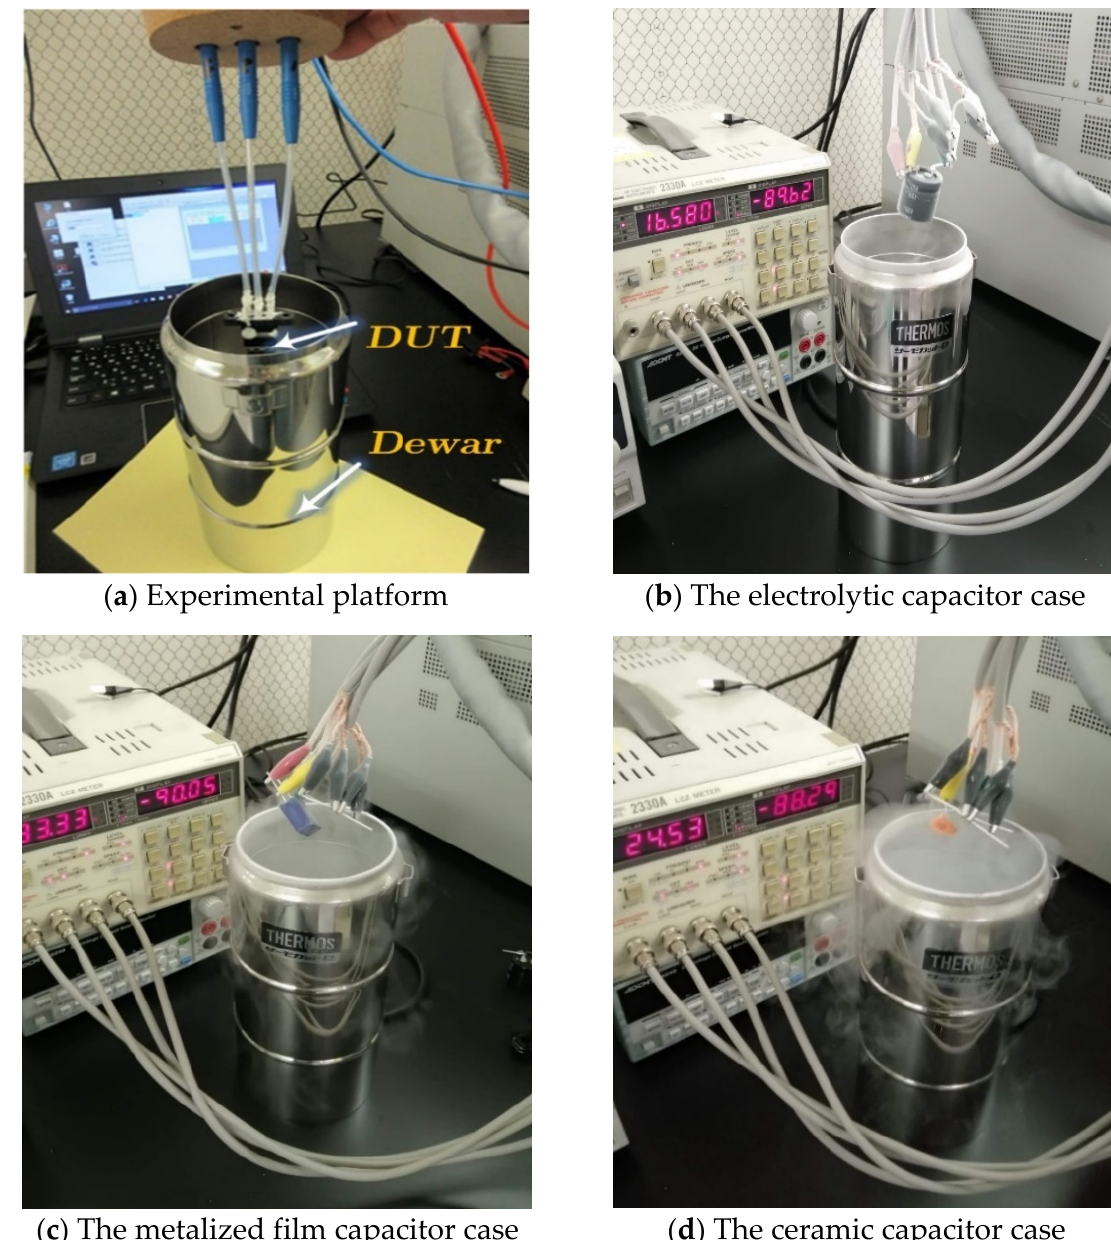
Figure 6. A schematic diagram of the experimental test setup.